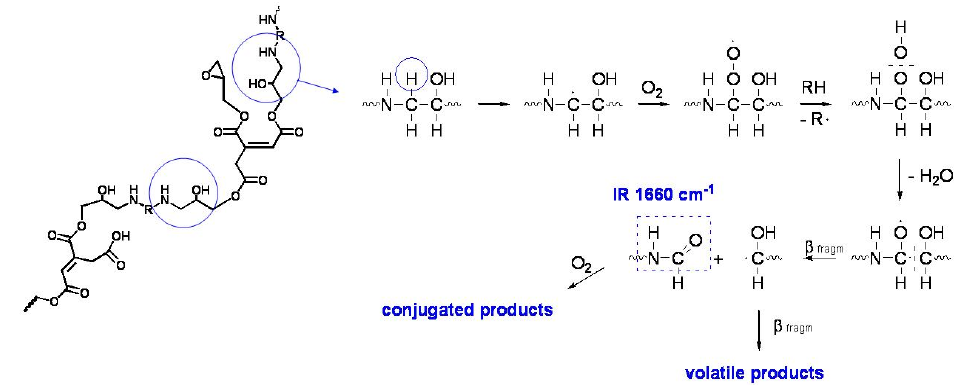
Figure 11. Simplified mechanism of oxidation of the aliphatic ER. The structure of the cured epoxy network is proposed based on the composition of the epoxy prepolymer and the polyamine hardener used for its preparation. Image reprinted with permission from [30].